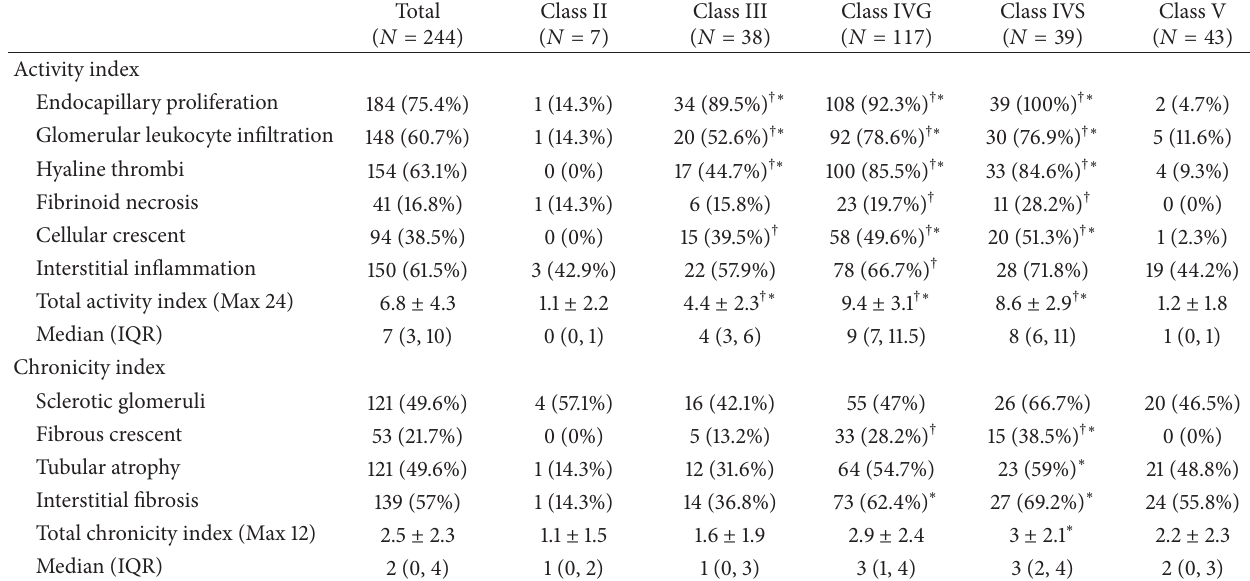
Table 3: The renal pathological findings at renal biopsy by LN